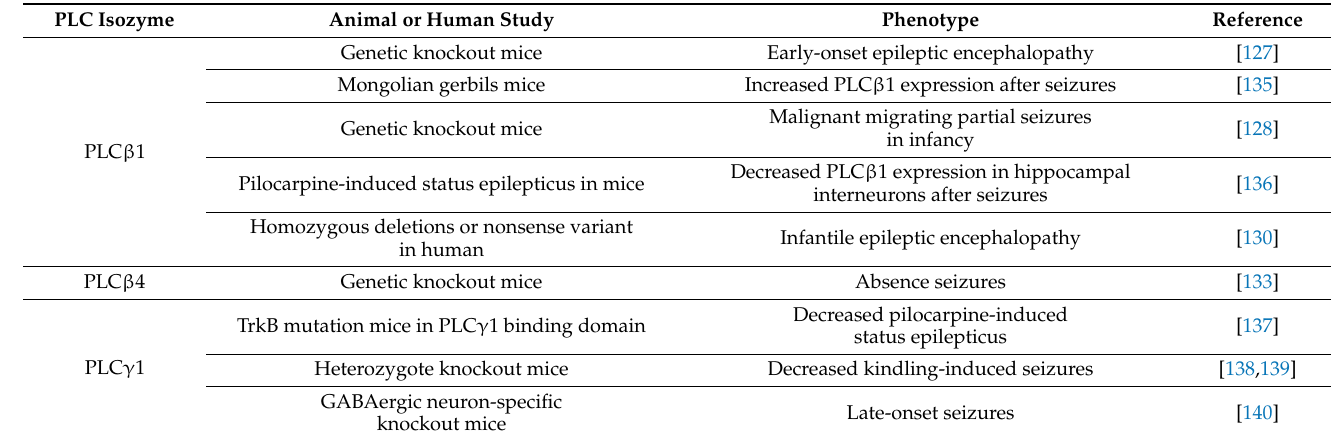
Figure 2. The functions of PLC β in GABAergic inhibition. ( a ) PLC β is activated by diverse GPCRs such as KA receptor, muscarinic receptor, and D2 receptor. Activation of PLC β suppresses presynaptic GABA release, resulting in increased excitation of postsynaptic neurons. ( b ) However, in other neuronal types, activation of PLC β by ethanol or serotonin increases presynaptic GABA release and consequently decreases the excitation of postsynaptic neurons. Table 3. The functions of PLC in epilepsy.